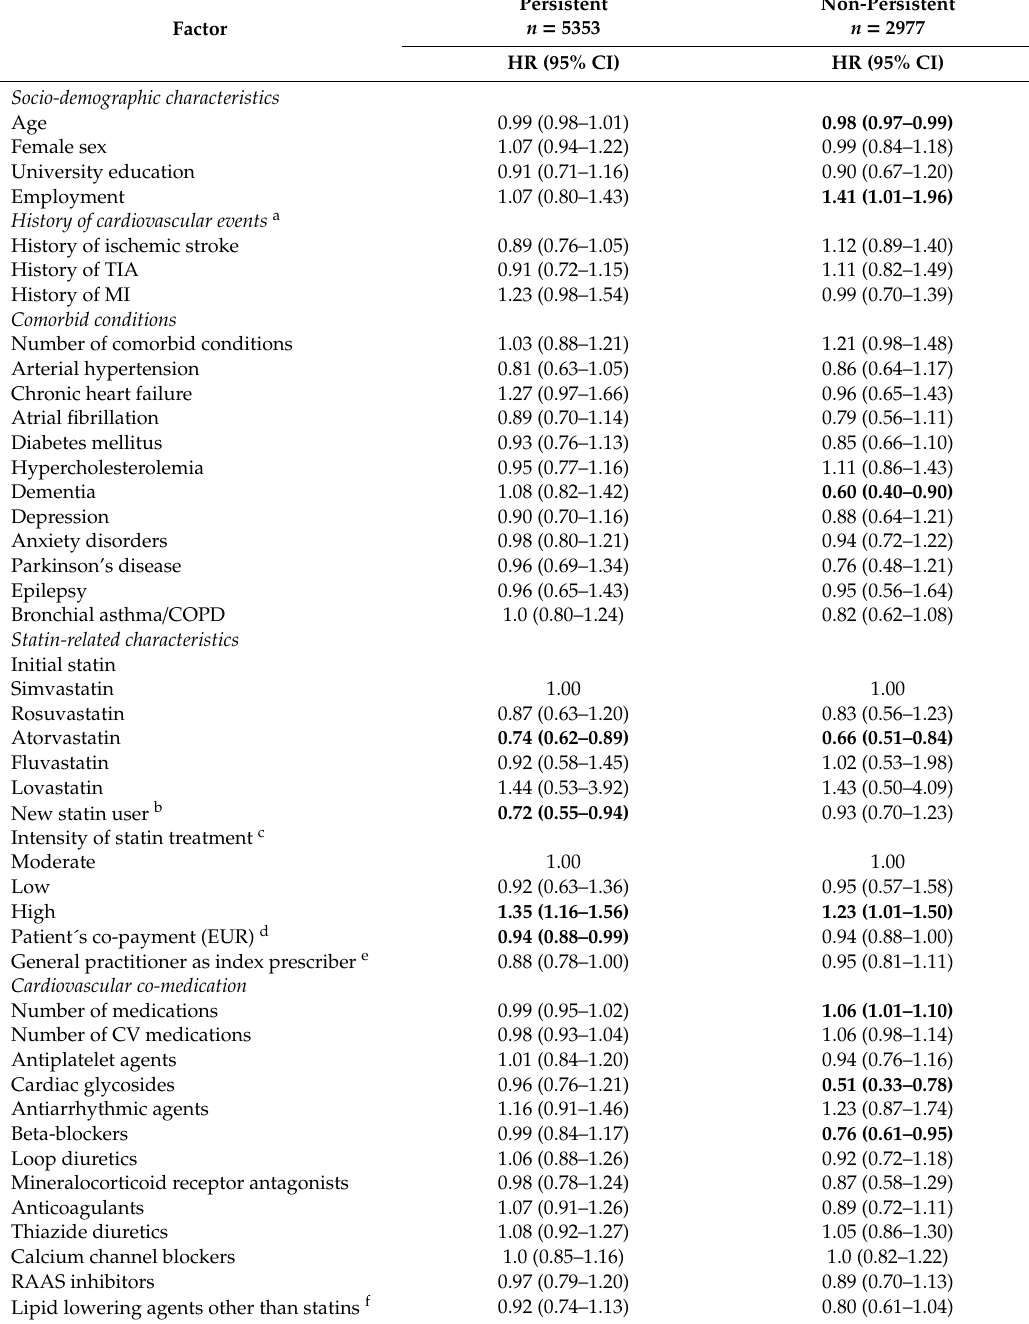
Table 2. Multivariate analysis of the influence of patient-associated characteristics on the likelihood of non-adherence ( n =